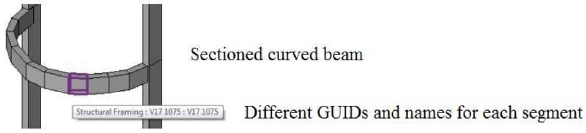
Fig. 9. Curved beam split into smaller parts